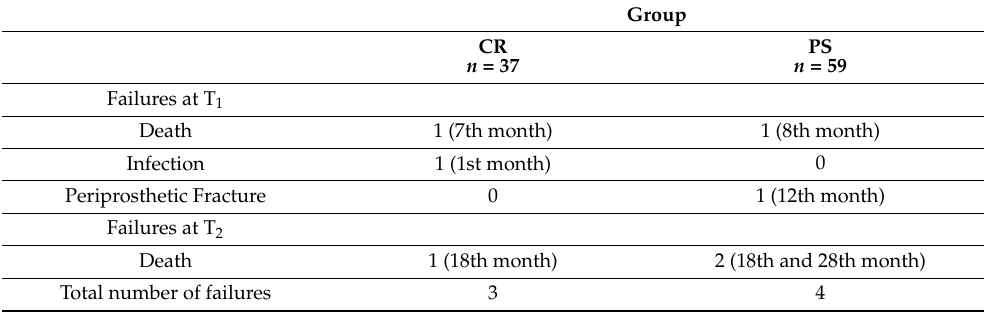
Table 3. Analysis of failures and complications for both groups during the study period.